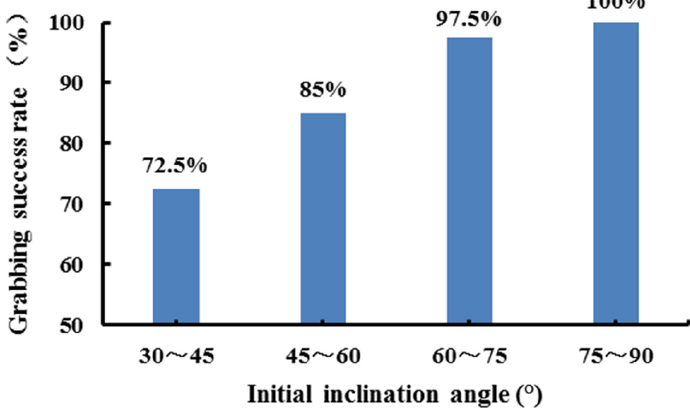
Figure 18. Grabbing success rate at different initial inclination angles. The grabbing success rate P s at different finger deflection speeds, ω , is shown in Figure 19. Less than 95% of P s were achieved at both the 20 ◦ s − 1 of ω and 80 ◦ s − 1 of ω , and were 92.71% and 94.79%, respectively. The highest 98.96% of P s was at the 40 ◦ s − 1 of ω . At 60 ◦ s − 1 and 100 ◦ s − 1 of ω , the P s was 96.88% and 95.83%, respectively. Variance analysis results indicated that the influence of finger deflection speed on the grabbing success rate was insignificant ( p = 0.5427). Suitable finger deflection speed for grabbing hydroponic Chinese kale should be in the range of 40 ◦ s − 1 to 60 ◦ s − 1 .